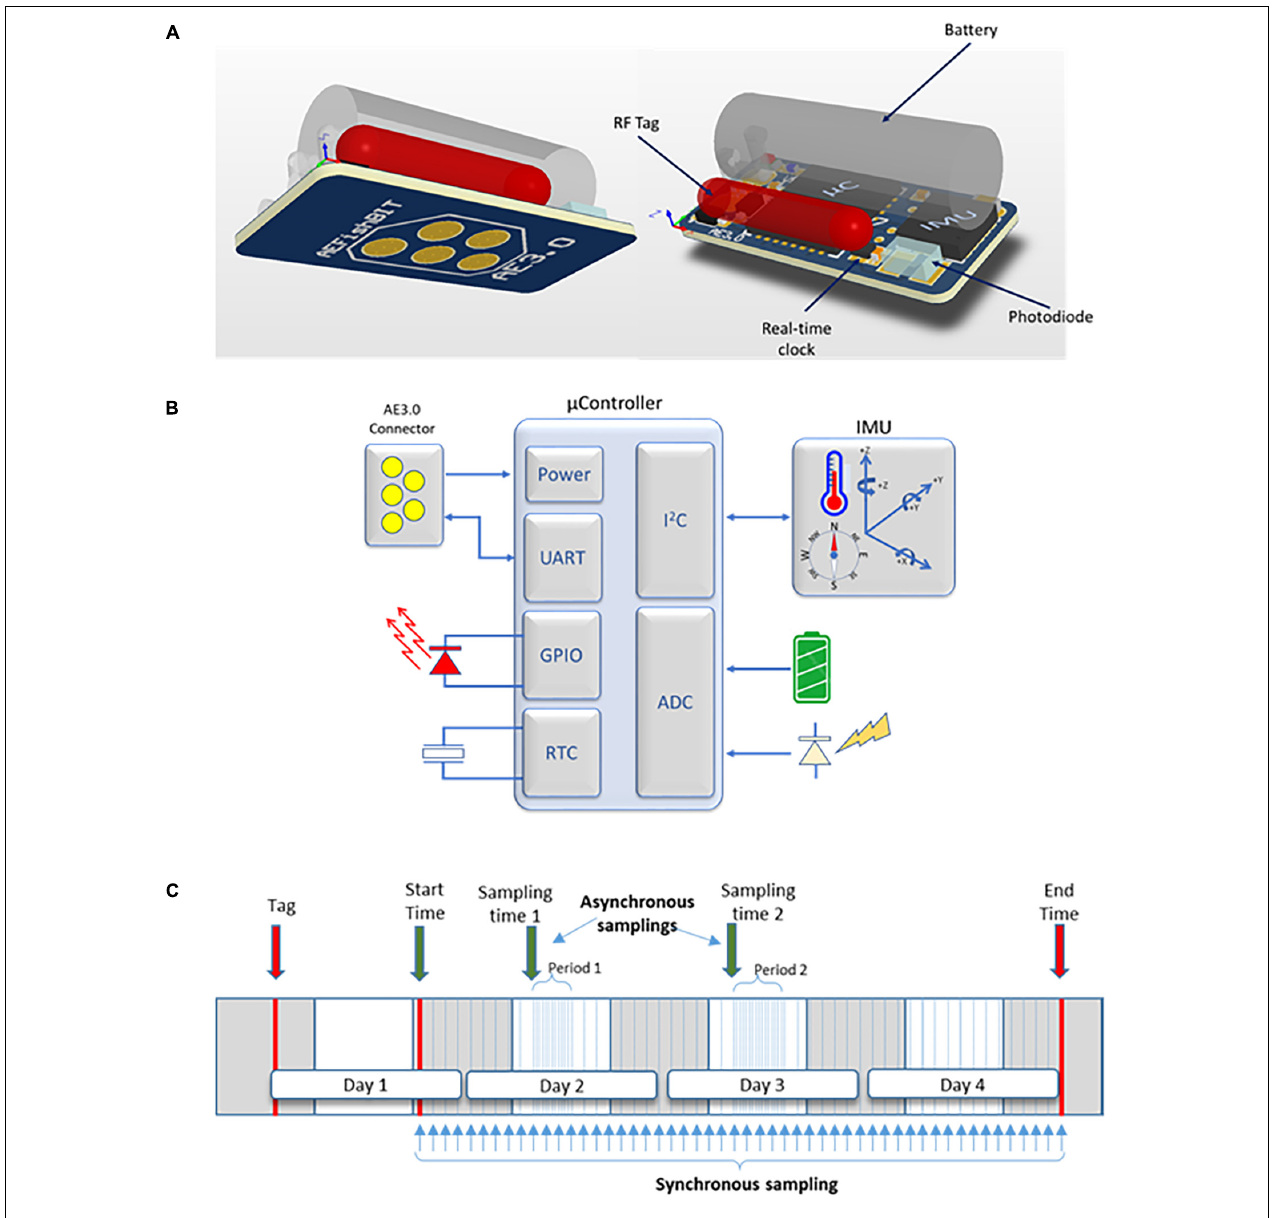
FIGURE 7 | (A) 3D view of unencapsulated AEFishBIT prototype. Connection pins are shown in the left image. Prototype includes a real-time clock and a photodiode to ensure device functioning under insulation conditions in aquatic environment. IMU: inertial measurement unit (accelerometer, gyroscope, magnetometer, thermometer). µ C: microcontroller. (B) Blocks diagram of AEFishBIT functioning. UART: universal asynchronous receiver-transmitter. GPIO: general purpose input/output. RTC: real-time clock. I 2 C: inter-integrated circuit. ADC: analog to digital converter for battery monitoring. (C) Diagram representation of AEFishBIT synchronous and asynchronous